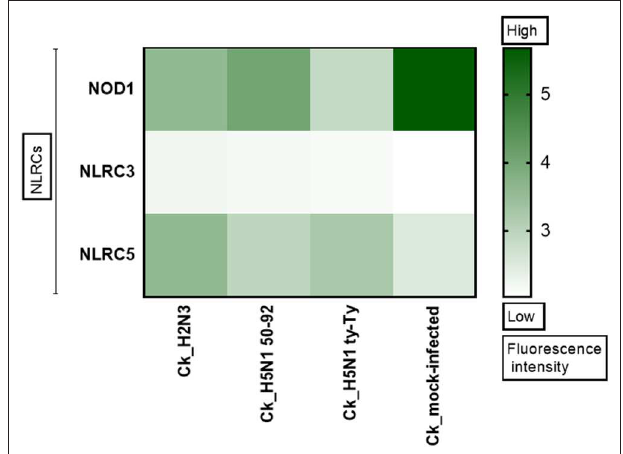
FIGURE 1 | NLRC5 expression is upregulated after AIV infection. The heat map shows the expression of three Nod Like Receptor (NLR) genes in primary chicken lung cells at 24h after infection with LPAIV A/mallard/duck/England/7277/06 (LPAI-H2N3), classical lineage HPAIV A/turkey/England/50-92/91 (H5N1-tyEng91) or contemporary Eurasian lineage HPAIV A/turkey/Turkey/1/05 (H5N1-tyTR05). Color corresponds to the expression levels of each gene from 0 (low expression) to > 5 (high